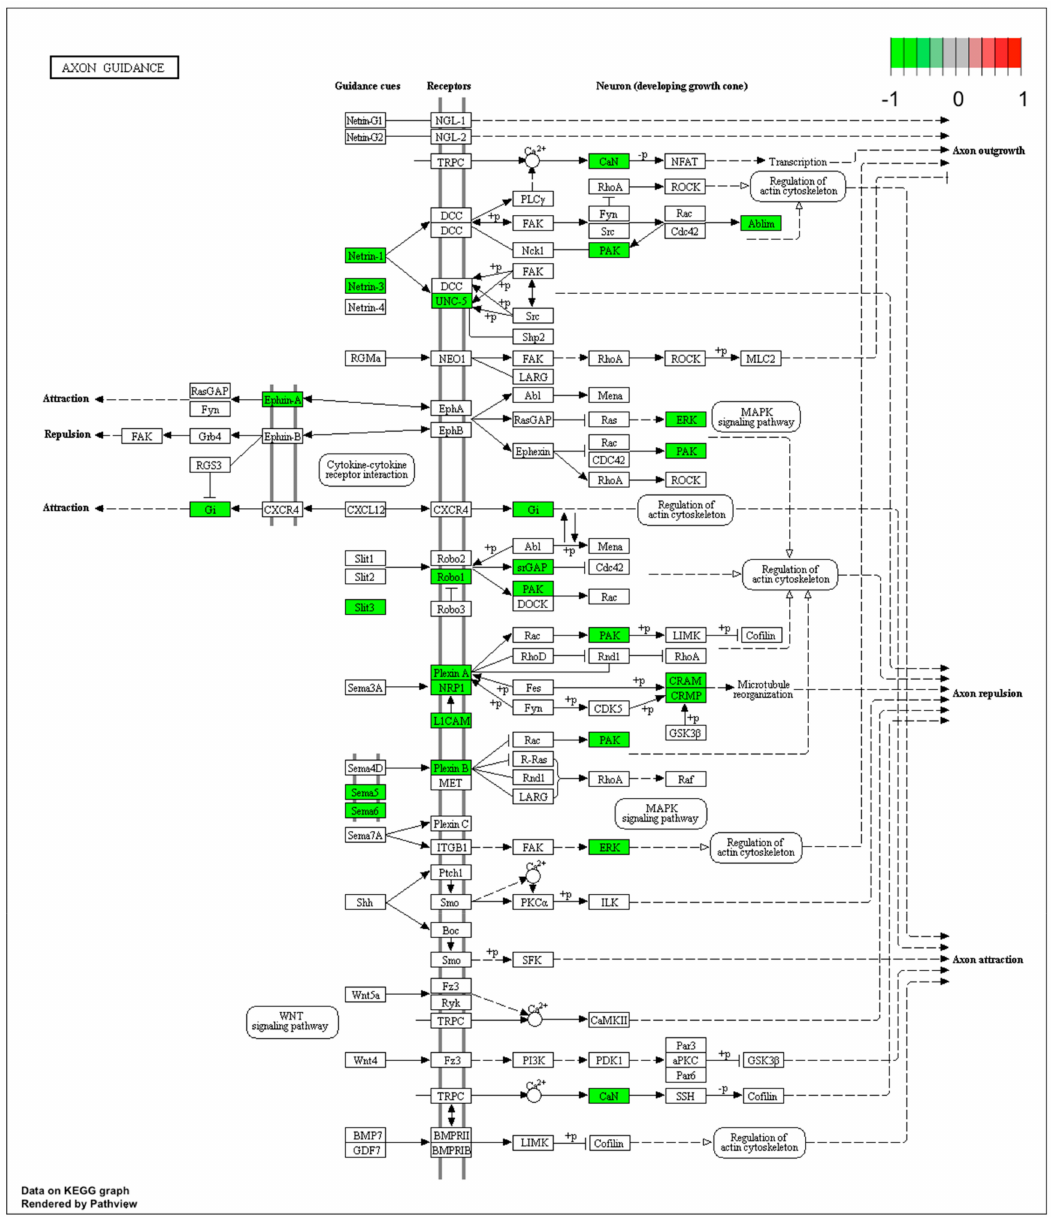
Figure 4. Graph of genes and processes involved in the pathway 04360.Axon guidance. The scheme shows genes and relationships between them. Additionally, the diagram indicates the genes up- or downregulated in our analysis. Solid arrows indicate a direct e ff ect on specific gene expression while dotted arrows indicate gene involvement in a process or pathway. This allows an in-depth understanding of the e ff ects of specific gene dysregulation on the selected